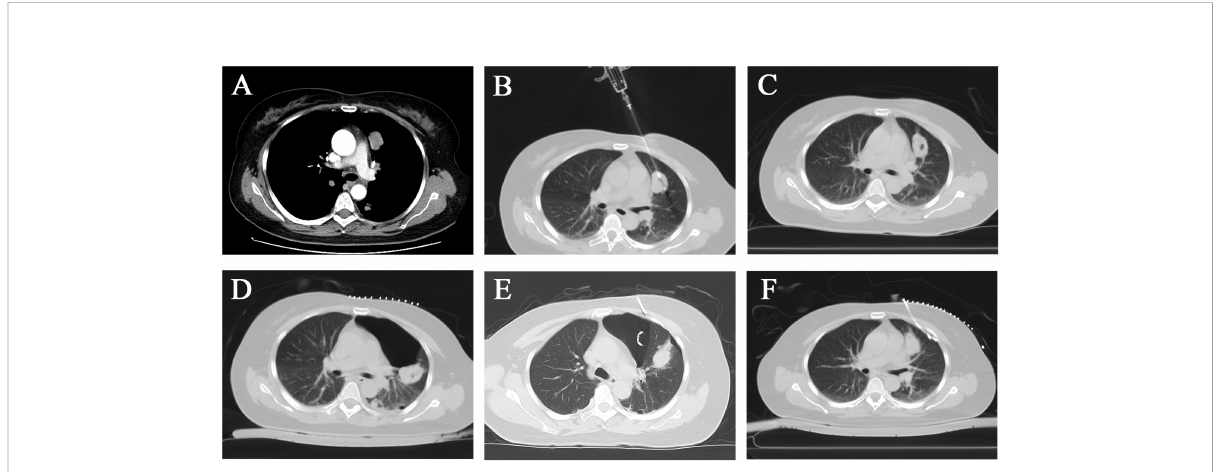
FIGURE 3 After CT-guided percutaneous biopsy, the patient developed pneumothorax and decreased oxygen saturation, which was treated with CT- guided tube drainage. (A) A left upper lobe mass with signi fi cant enhancement. (B) The needle slot of the 18G semi-automatic puncture needle was located in the center of the tumor. (C) No signi fi cant postoperative bleeding or pneumothorax was observed. (D) Pneumothorax was caused by the harsh coughing of the patient. (E) The patient was treated with a chest tube for drainage. (F) The pneumothorax had utterly disappeared after 1